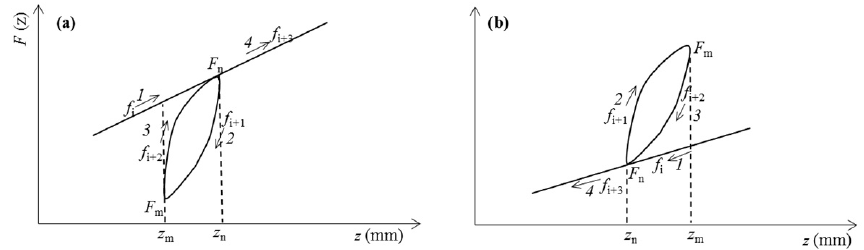
Figure 4. Numerical implementation of internal hysteresis loop: (a) internal loop on an ascending external curve, (b) internal loop on a descending external curve